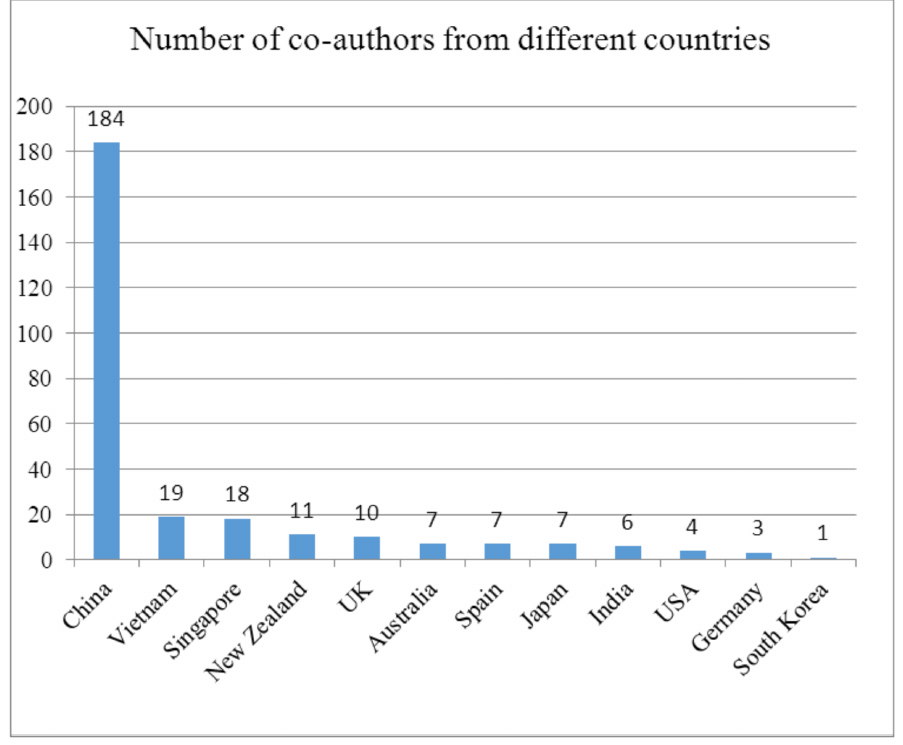
Figure 5. Number of co-authors from different